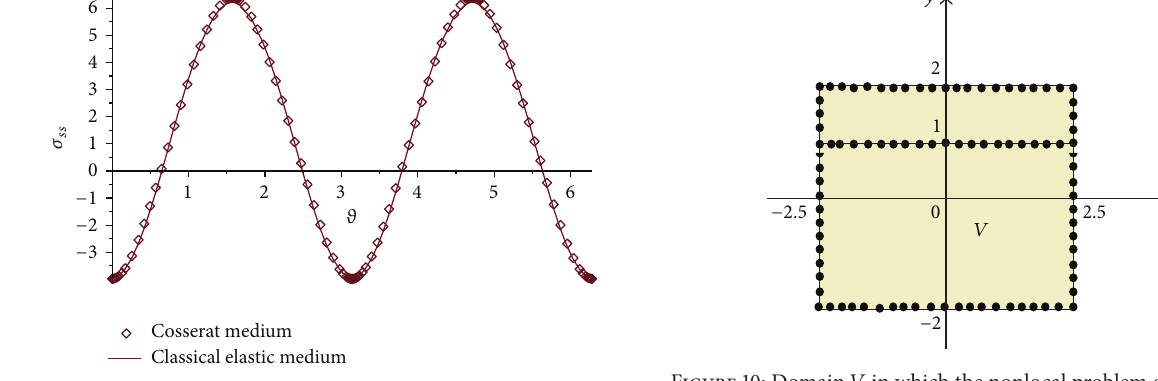
Figure 9: Graphs of the distribution of stress 𝜎 𝑠𝑠 along the hole con- tour for the classical medium and the Cosserat medium for domain Ω 2 .